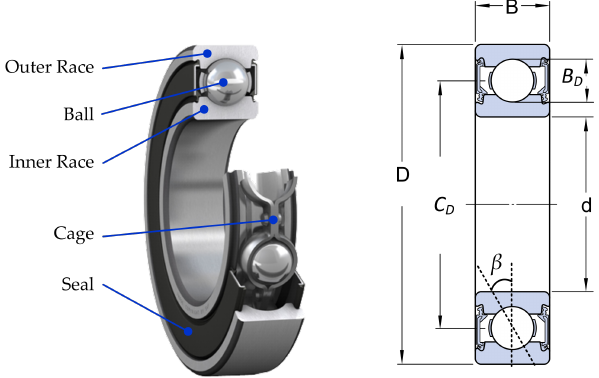
Figure 1. Geometry of a rolling element bearing.